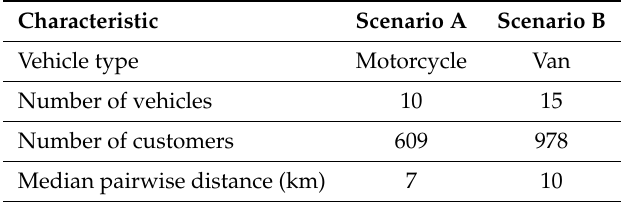
Table 1. Characteristics of problems in Scenarios A and